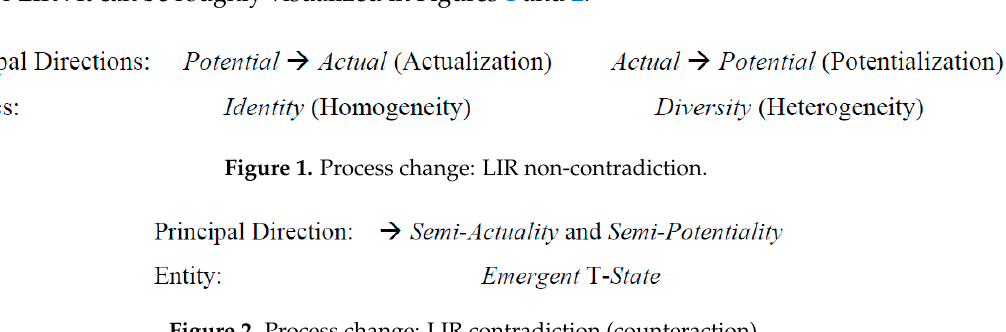
Figure2. Process change: LIR contradiction (counteraction).